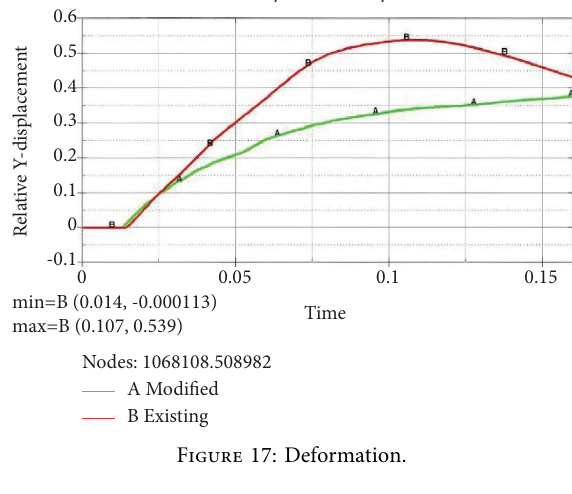
Figure 17: Deformation.